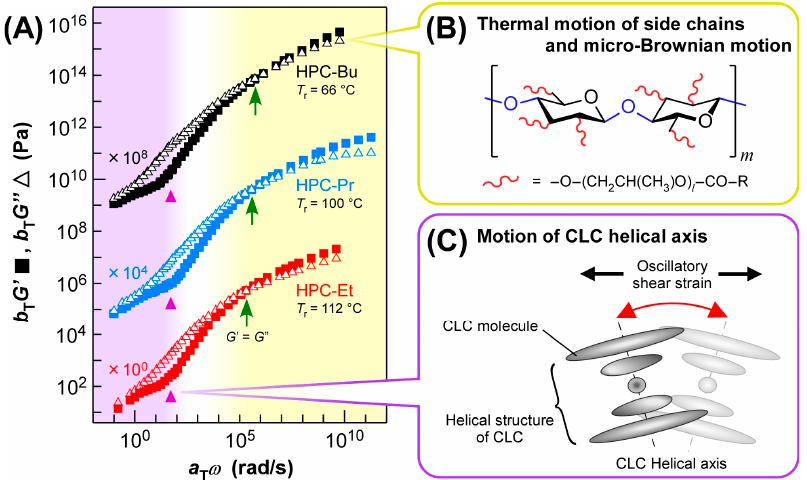
Figure 5. ( A ) Master curves of HPC-Et (red plots, lower profiles), HPC-Pr (blue plots, middle profiles), and HPC-Bu (black plots, upper profiles) with reference temperatures ( T r ) at which these HPC derivatives showed a reflection peak at 405 nm. All the master curves were prepared by time–temperature superposition (TTS) principle. The values of a T and b T are horizontal and vertical shift factors, respectively. Note that the master curves of HPC-Pr and HPC-Bu are shifted in the vertical direction of profiles by increasing both b T G ′ and b T G ″ values for the reader’s clarity. The green arrows stand for the intersections of G ′ and G ″ , and the purple triangles are the inflection points of G ′ . ( B ) Schematic illustration of the dominant relaxation process in the higher ω region (the region highlighted in yellow in Figure 5A). In this illustration, l means the number of repeating propyleneoxy units of HPC. ( C ) Schematic illustration of the dominant relaxation process in the lower ω region (the region highlighted in purple in Figure 5A).